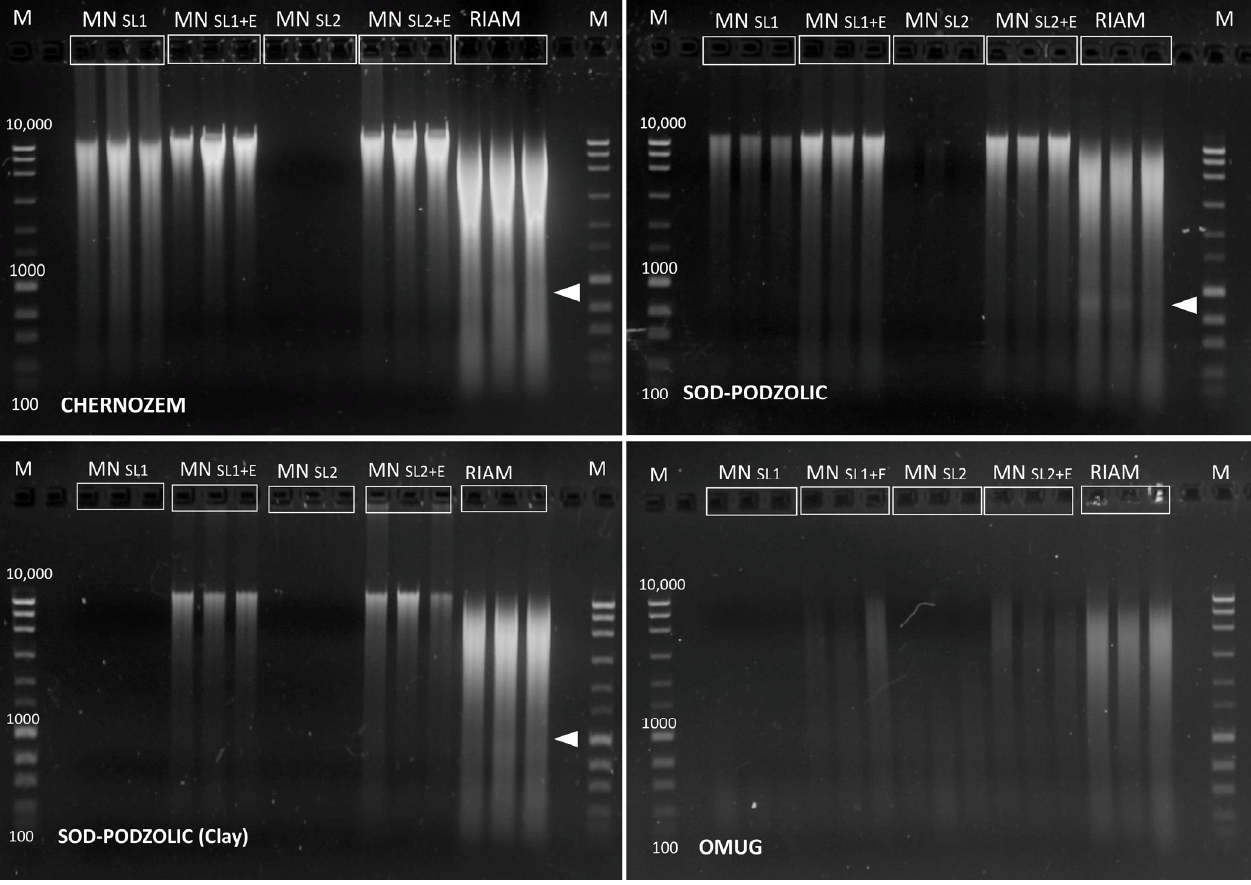
Figure 1. Electrophoretic separation of DNA isolated from four types of substrates with the NucleoSpin Soil kit with four different buffers and with the RIAM protocol developed in this study. M—molecular weight marker. MN SL1, SL1+E, SL2, SL2+E—buffer versions of NucleoSpin Soil kit (Macherey-Nagel, Germany). The white triangle marks a place where a weak band of 16S rRNA is visible.